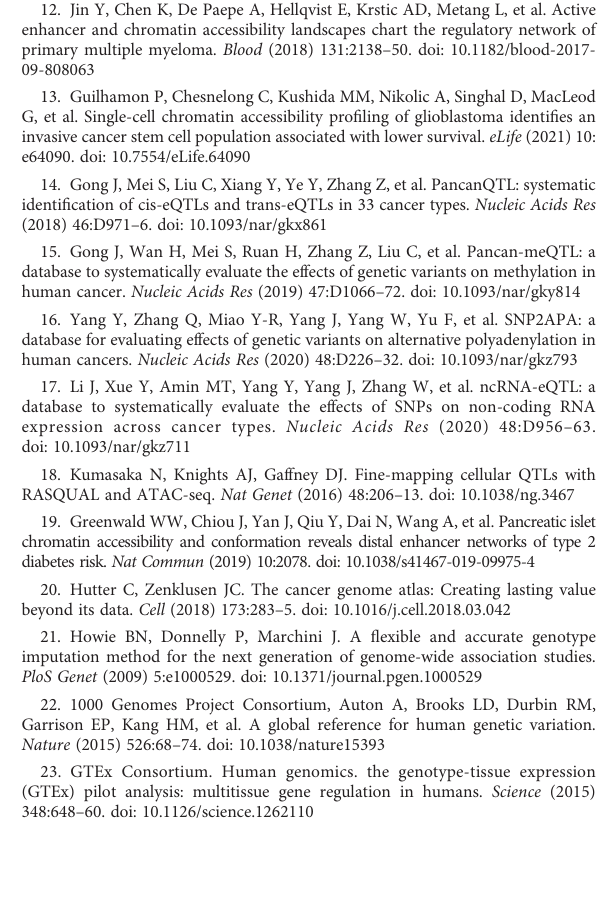
SUPPLEMENTARY FIGURE 1 Enrichment of ATAC-peaks in different chromatin states across 23 cancer types. The background peaks were genomic regions with the same width randomly selected. SUPPLEMENTARY FIGURE 2 Differences in gene expression levels between genes with ATAC-peaks overlap withtheTSS,andthosewithoutATAC-peaks